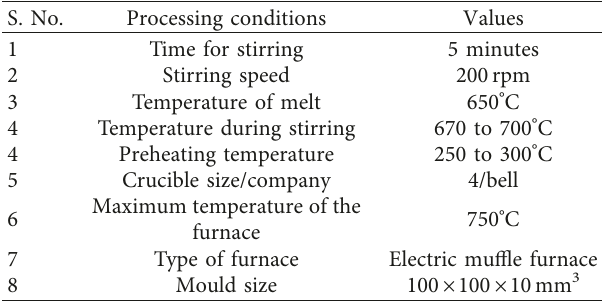
Table 4: Control factors – stir casting process. S.